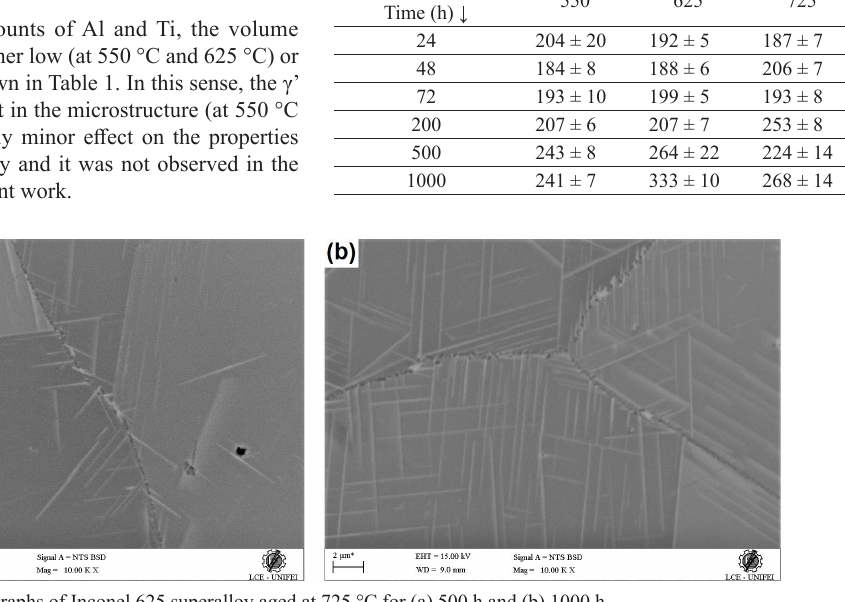
Figure 3. SEM/BSE micrographs of Inconel 625 superalloy aged at 725 °C for (a) 500 h and (b) 1000 h.